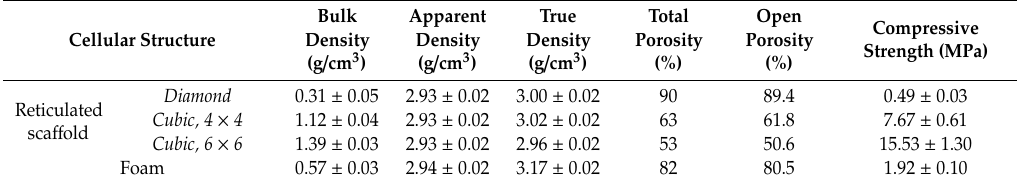
Table 2. Summary of density and compressive strength data for all developed cellular glasses. Cellular